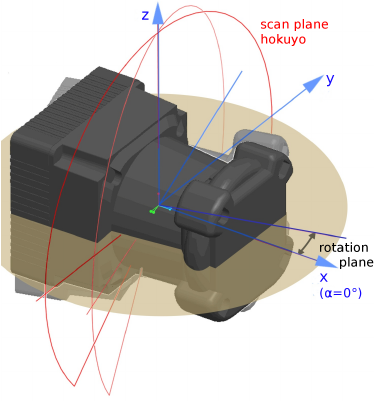
Figure 3: Koordinate system and scannig plane of rotating Hokuyo